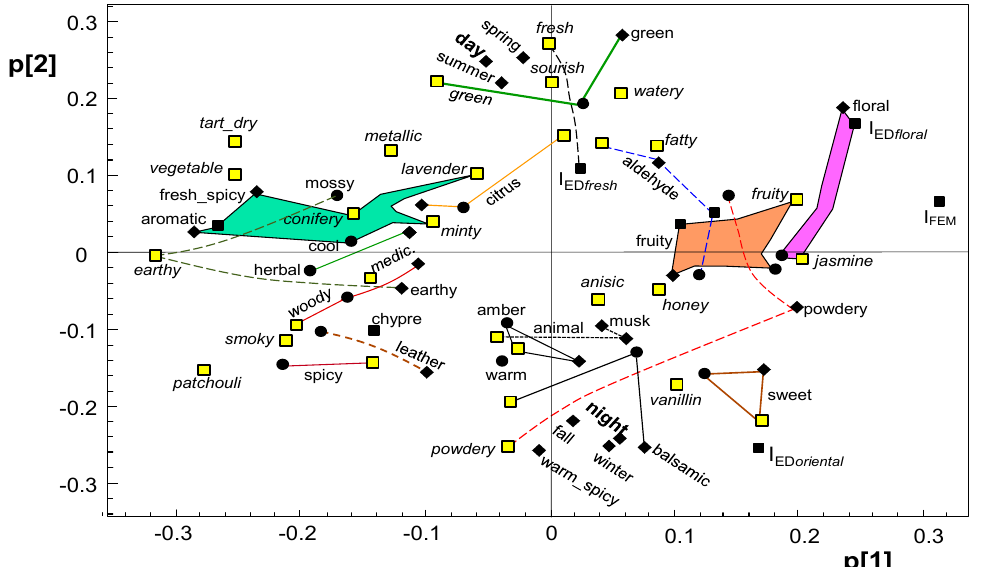
Figure 2. Loading plot ( p (2) vs. p (1)) of the principal component analysis (PCA) applied to the olfactory profiles (48 variables) obtained for the 176 perfumes from Fragrantica and several perfume guides (see Table 1 for the lists of variables included and point codes). The loading plot ( p (1) vs. p (2)) of the Boelens–Haring database [30] was superimposed (yellow squares; labels in italics) after being properly scaled. Equivalent descriptors are joined with lines. Fruity and floral scents (colored polygons) are the ones that are most typically feminine, while aromatic and related notes (green polygon) are commonly found in men’s